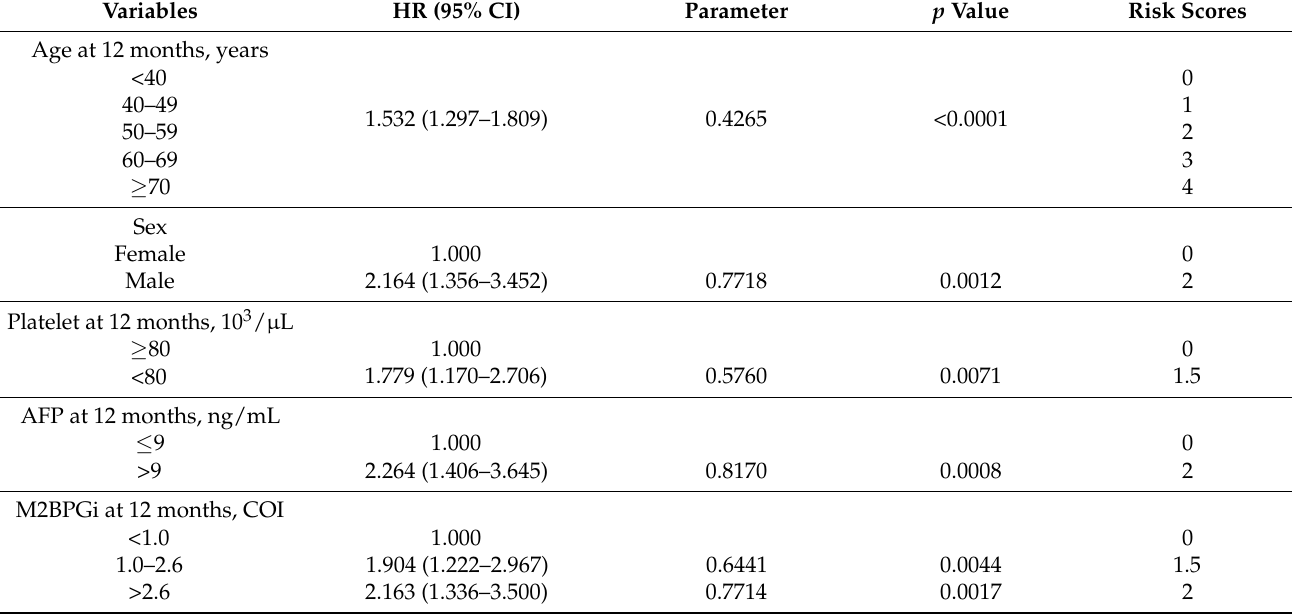
Table 3. The risk scores of hepatocellular carcinoma in the development